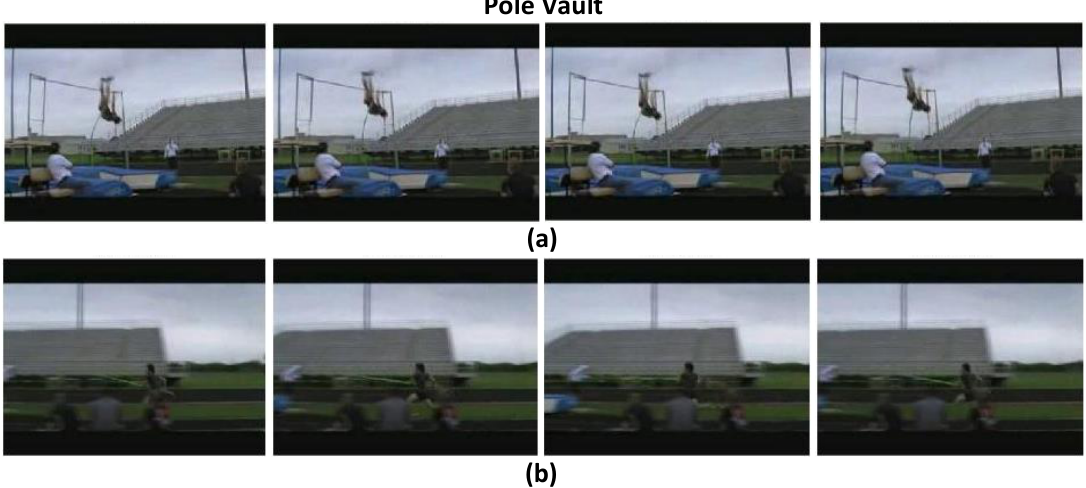
Figure 6. ( a ) The highest ranking four frames in terms of attention weights, in which the athlete is pole-vaulting. ( b ) The lowest ranking four frames in terms of attention weights, , in which the athlete is running